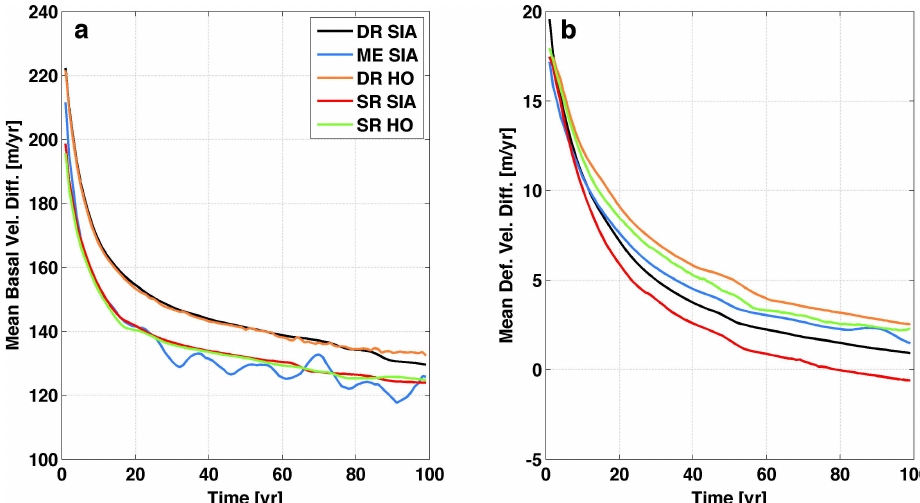
Fig. 8. Spatially averaged velocity response in MarAsl2 for the marginal sliding region decomposed into its basal (a) and mean deformational component (b) . Background velocities from an unforced control experiment are subtracted. Due to changes in the extent of the sliding area, both velocity components were smoothed using a 5yr running